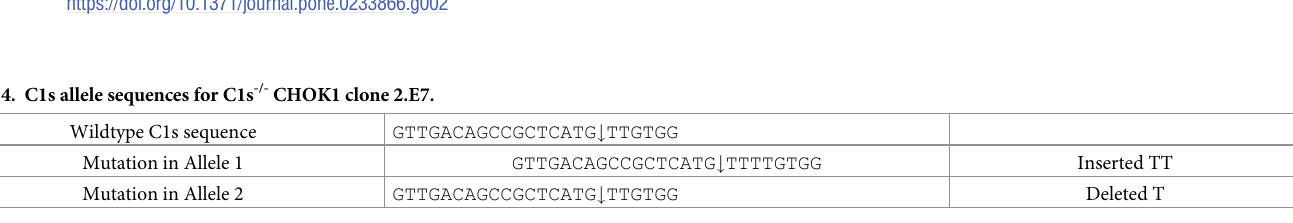
Fig 2. Selection of C1s -/- CHOK1 2.E7. A. A schematic for the C1s gene, containing 11 exons. The single guide RNA targeting exon 11 used to direct Cas9 is indicated by the arrow. B. Clones with both alleles of C1s knocked out were screened by Western Blot. 100 ng of purified BaL-rgp120 was incubated with 15 ul of supernatant from 24 well plates overnight at 37˚C. Samples were run reduced with DTT. Clones marked with a black box have knockouts of both alleles as verified by sequencing. C. Bal-rgp120 was transiently transfected into C1s -/- CHOK1 clones 2.E7, 2.E9, and 3.E8 and cultures were grown for 6 days. 5 ul of supernatant was run reduced with DTT on Western Blot. D. The sequence around the expected indel site was analyzed by TIDE (Tracking of Indels by Decomposition, tide.deskgen.com) for clone 2.E7 to check for knockout of both alleles. The indel site was amplified by PCR from genomic DNA extracted from the CHO cell clone and Sanger sequenced. The peaks from Sanger sequencing chromatograms are decomposed to determine the proportion and identity of the indels present in the clone.